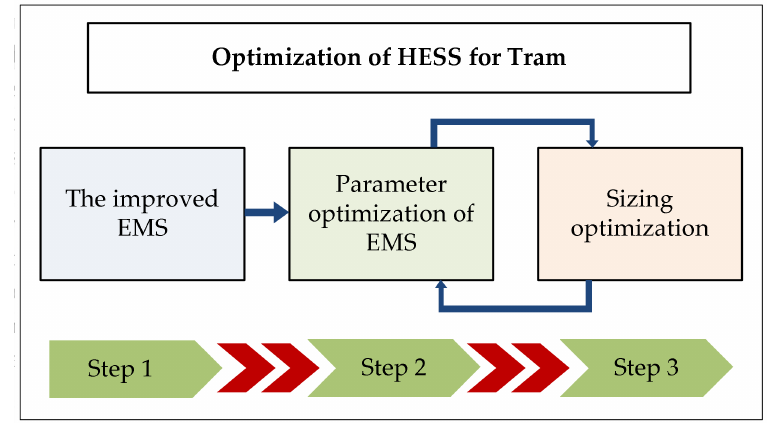
Figure 1. Optimization steps for hybrid storage system.